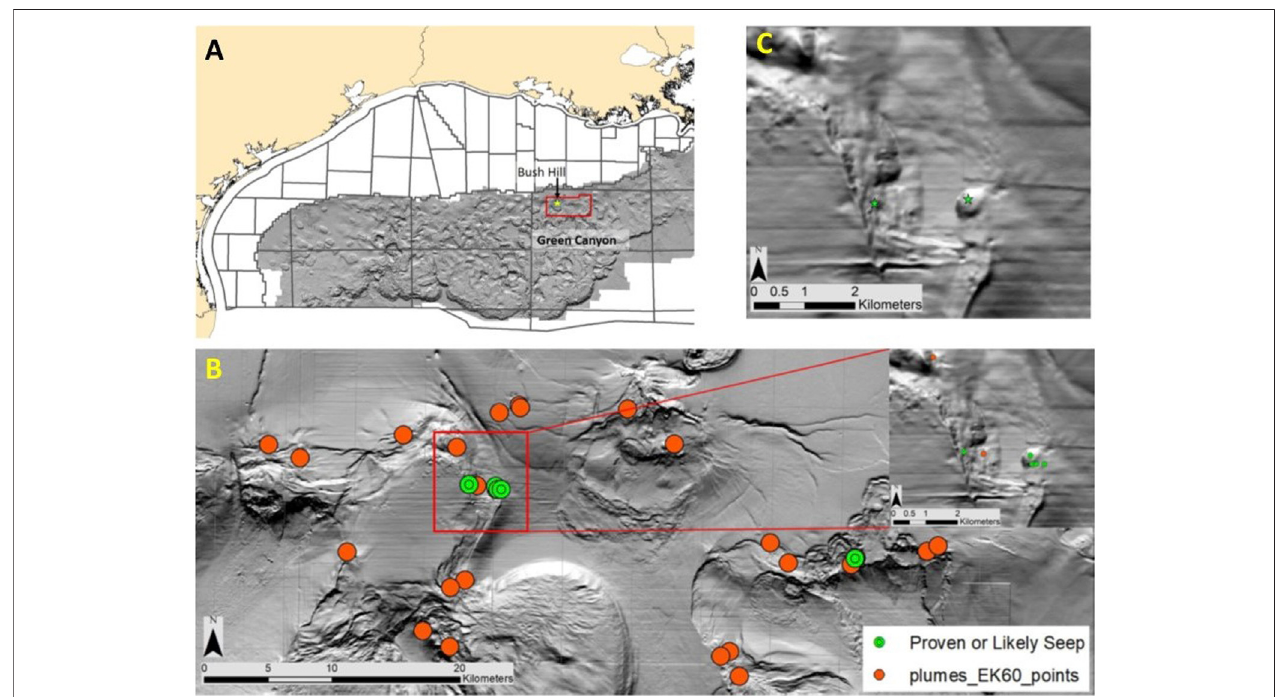
FIGURE 1 | General and more detailed location maps are provided in (A – C) . (A) Shows the outline of the area covered by our Bureau of Ocean Energy ManagementgeologicalexplorationpermitinthecontextoftheTexas-Louisianacoastline,protractionpolygons,andslopebathymetry.ThelocationoftheBushHillmud volcanoisindicatedbyastar. (B) ProvidesadetailedMBES(multibeamechosounder)shadedmapwiththelocationsofoil-bearingdropcoresandbubbleplumes.There isan insetzoom ofthearea around Bush Hill. (C) Zoom ofthe Bush Hillarea withstars indicating the location ofthemud volcanoand the seepage site onthe slope to west of